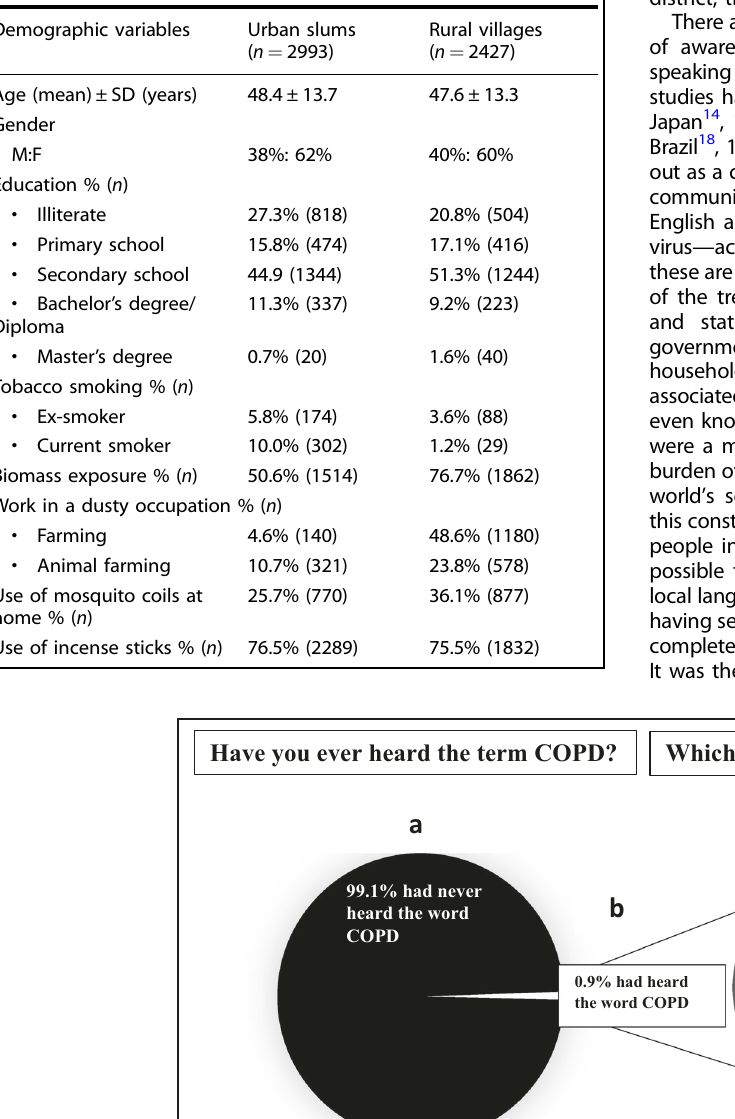
Table 1. Demographic details describing the study population.